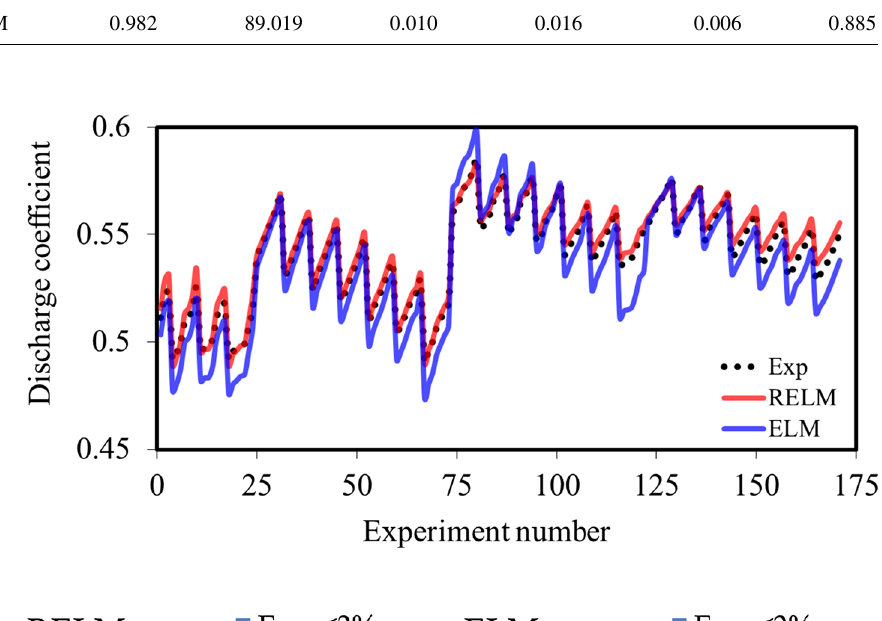
Fig. 14 Error analysis outcomes for RELMs and